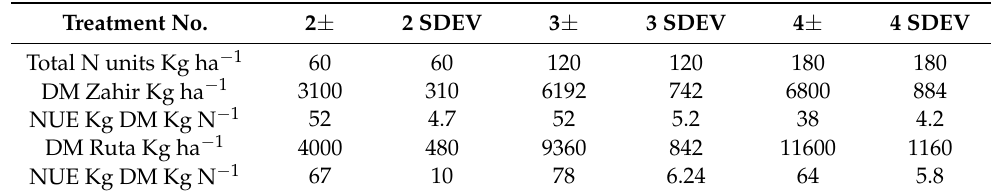
Table 6. The effect of Nitrogen application dose on final canopy weight and Nitrogen use effi- ciency (NUE).